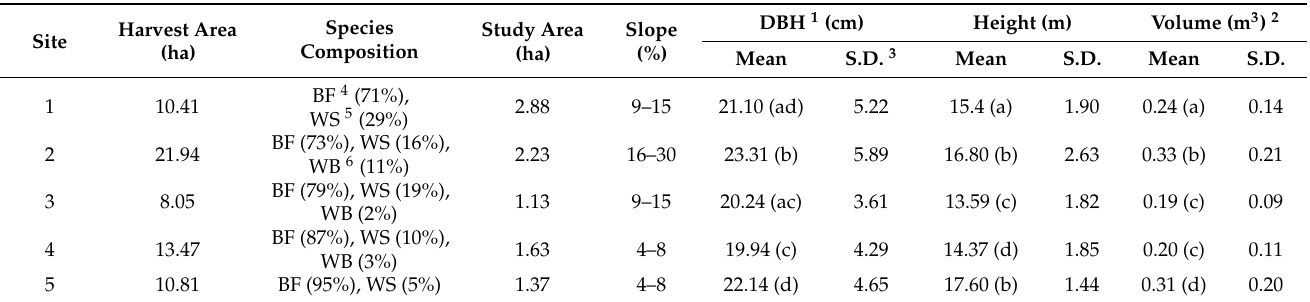
Table 1. Site composition of the five harvest areas including mean DBH, height and volume of the five study sites. Statistical differences (aov function) based on Tukey test (Tukey HSD function) between study area characteristics are illustrated in parentheses.